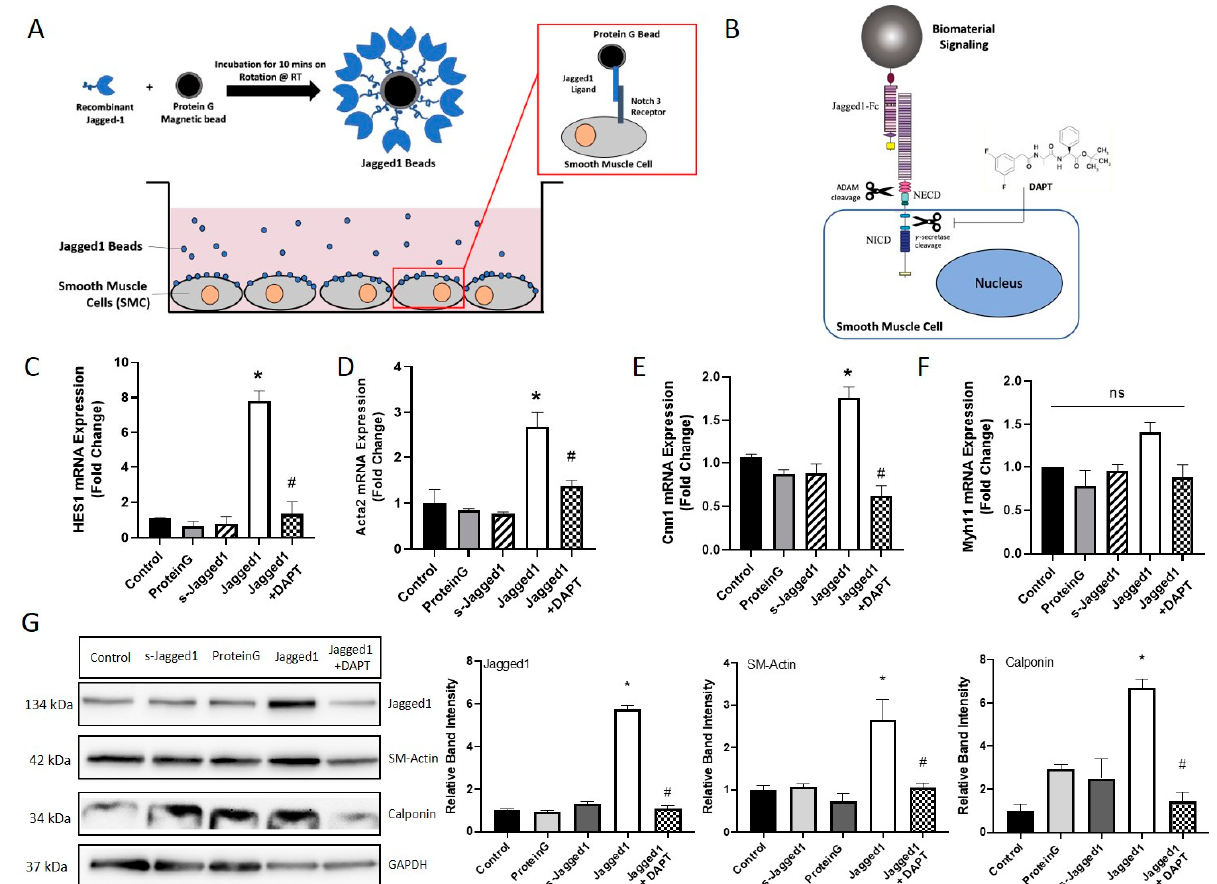
Figure 1. Bead-bound Jagged1 directs HCASMC contractile gene and protein expression. ( A ) Schematic drawing of Jagged1 affinity immobilization and bead-bound Jagged1 co-culture with HCASMCs. ( B ) Schematic drawing of DAPT inhibition of the γ -secretase intracellular cleavage, stopping the NICD from translocating to the nucleus. The effect of soluble and bead-bound Jagged1 was investigated, and a Notch-specific response was determined using 10 µ M DAPT as Notch inhibitor. The control cells are untreated HCASMCs cultured in SmGM-2. ( C – F ) Gene expression of HES1 , Acta2 , Cnn1, and Myh11 . ( G ) Representative Western blots of Jagged1, SM-Actin, and Calponin and the corresponding quantified band intensities. All data are normalized to the control and presented as the mean ± SD, n = 3. * indicates significance from the control, and # indicates significant downregulation from the Jagged1 treatment group at p < 0.05, ns indicates no statistical